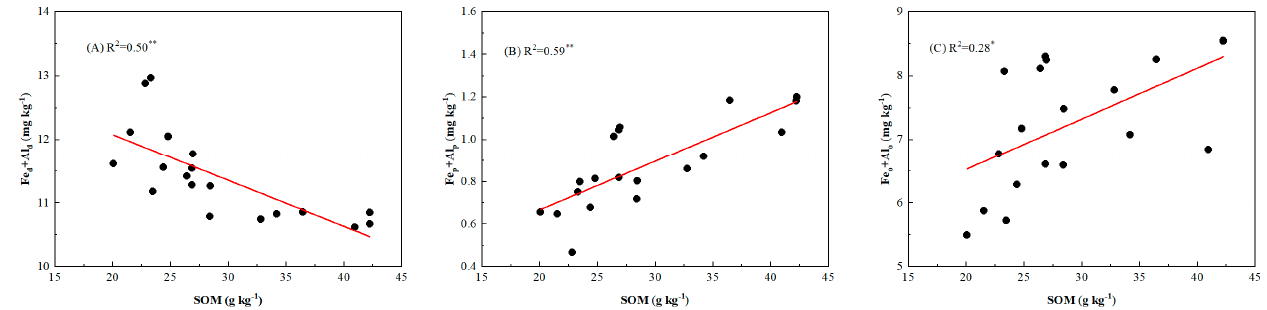
Figure A2. The relationship between SOM and Fe d + Al d ( A ), Fe p + Al p ( B ), and Fe o + Al o ( C ) under long-term field trial. Fitted curves were: y = Kx + b. SOM, soil organic matter; Fe d and Al d , crystalline iron and aluminum oxide; Al o and Fe o , amorphous Al and Fe oxide; Al p and Fe p , organic-bound iron and alumina oxide. * and ** mean the relationship between total P and P fraction in p < 0.05, p < 0.01 level, respectively.